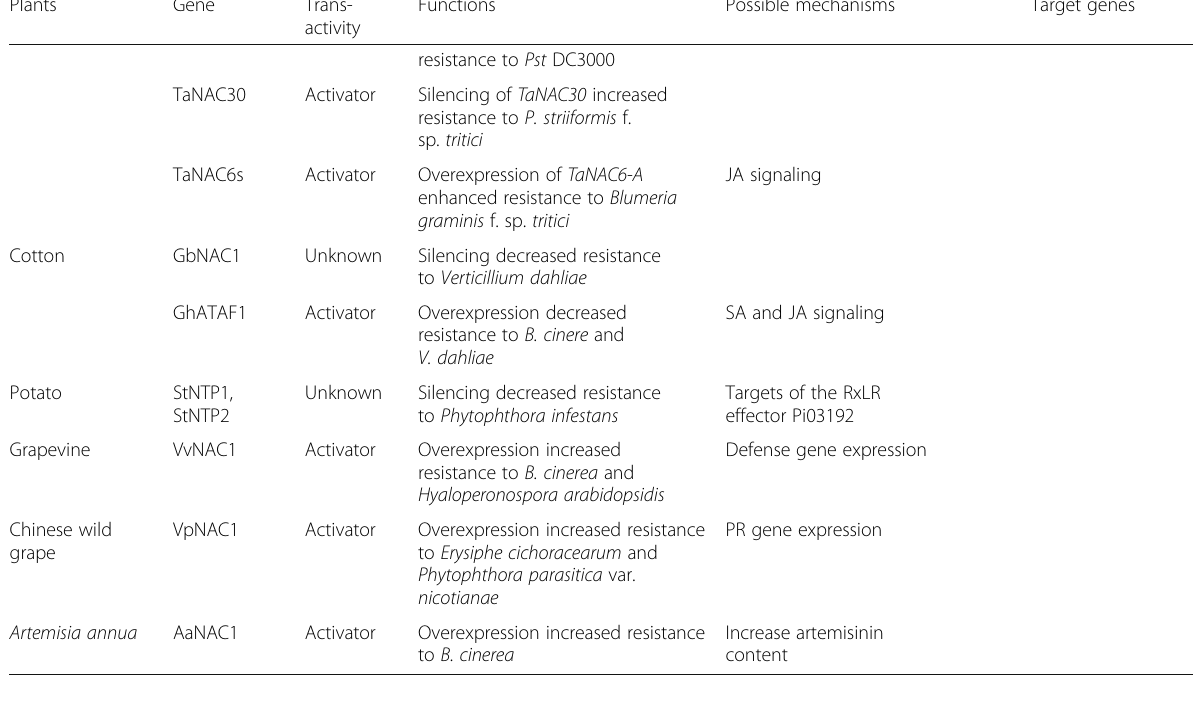
Table 1 Functional and biochemical features of the reported immunity-related NAC transcription factors (Continued) Plants